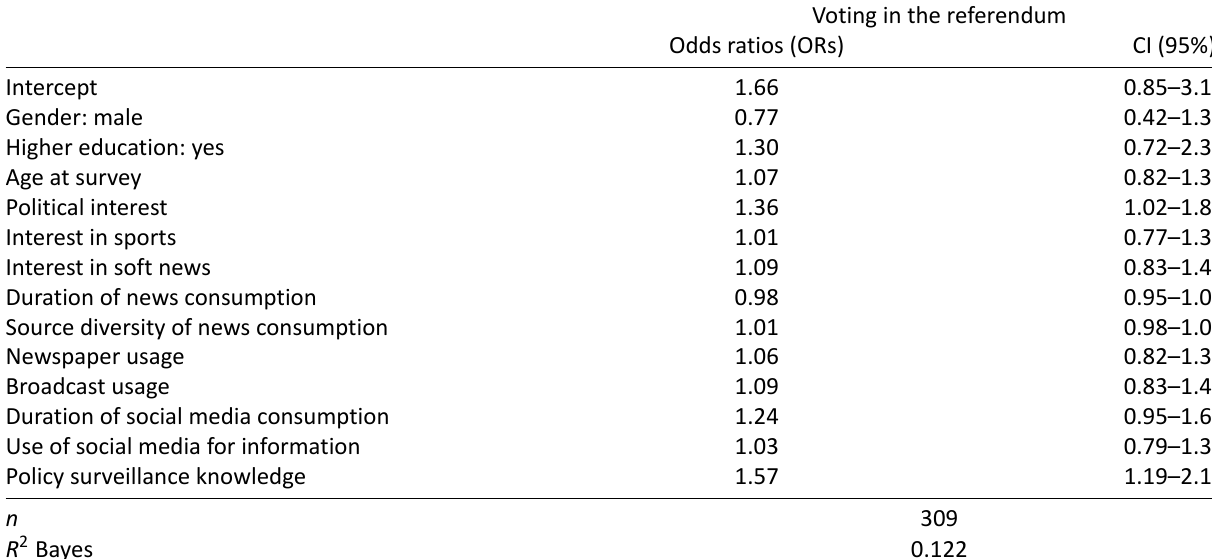
Table 3. Binary logistic regression model for participation in the